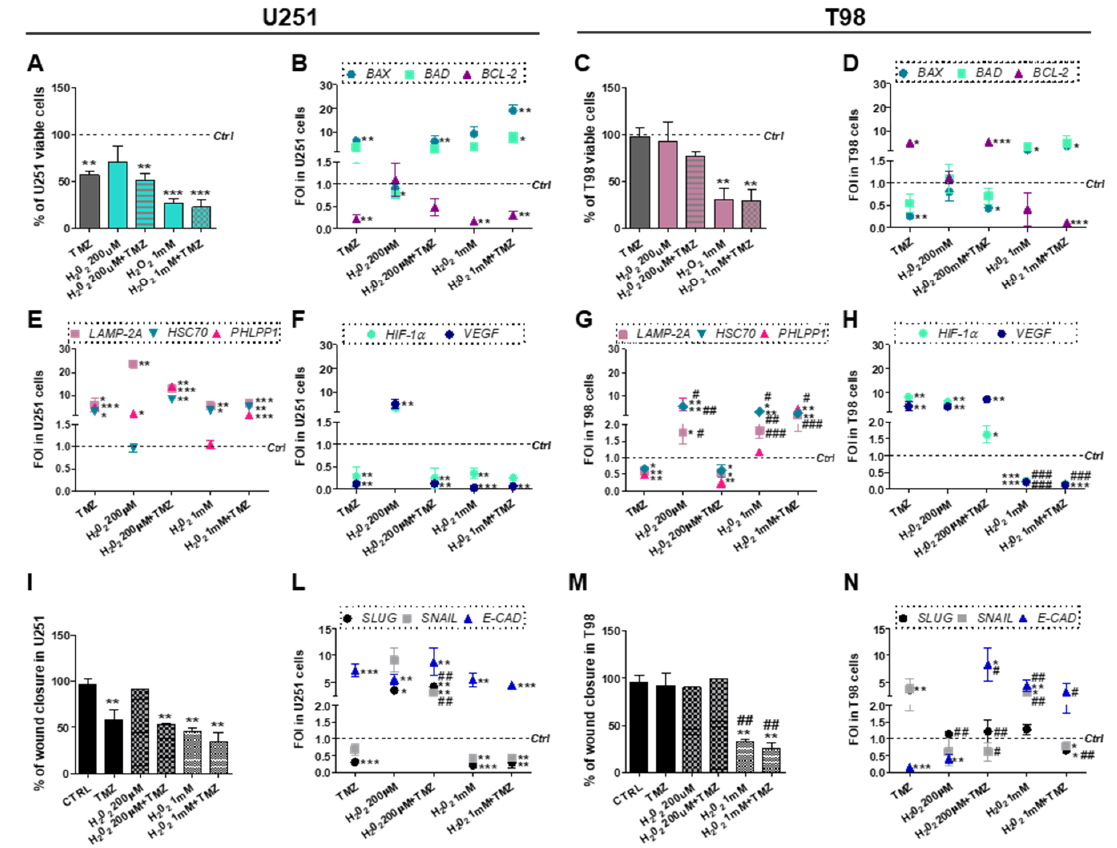
Figure 5. Role of oxidative stress in overcoming Temozolomide resistance. ( A ) Viability analysis and ( B ) gene expression profile for apoptotic-related genes ( BAX , BAD and BCL-2 ) in U251 and ( C , D ) in T98 cells. Viability was assessed by means of Trypan blue exclusion test after treatment with 200μM or 1mM H 2 O 2 ± 100 μM Temozolomide (TMZ). Data of viability were expressed as percentage of viable cells; ** p < 0.01; *** p < 0.001 treated vs. control cells. ( E ) Gene expression profile for CMA-related genes ( LAMP2A , HSC70 , PHLPP1 ), and for ( F ) HIF-1α and VEGF in U251 and in ( G , H ) T98 cell after treatment with 200 μM or 1 mM H 2 O 2 ± 100 μM TMZ. * p < 0.05; ** p < 0.01; *** p < 0.001 treated vs. control cells. All data of gene expression were normalized for β-ACTIN , and the ΔΔCt values were expressed as FOI of the ratio between treated and control cells. * p < 0.05; ** p < 0.01; *** p < 0.001 treated vs. control cells. # p < 0.05, ## p < 0.01, ### p < 0.001 vs. TMZ-treated cells. ( I ) Scratch test and ( L ) gene expression for EMT-related genes ( SLUG , SNAIL , E-CAD ) performed after treatments in U251 and ( M , N ) T98 cells. Wound closure percentage compared to control was analyzed with Image J software. ** p < 0.01 treated vs. control cells. ## p < 0.01 vs. TMZ-treated cells. Data of gene expression were normalized and expressed as mentioned above. * p < 0.05; ** p < 0.01; *** p < 0.001 treated vs. control cells. # p < 0.05, ## p < 0.01, ### p < 0.001 vs. TMZ-treated cells.